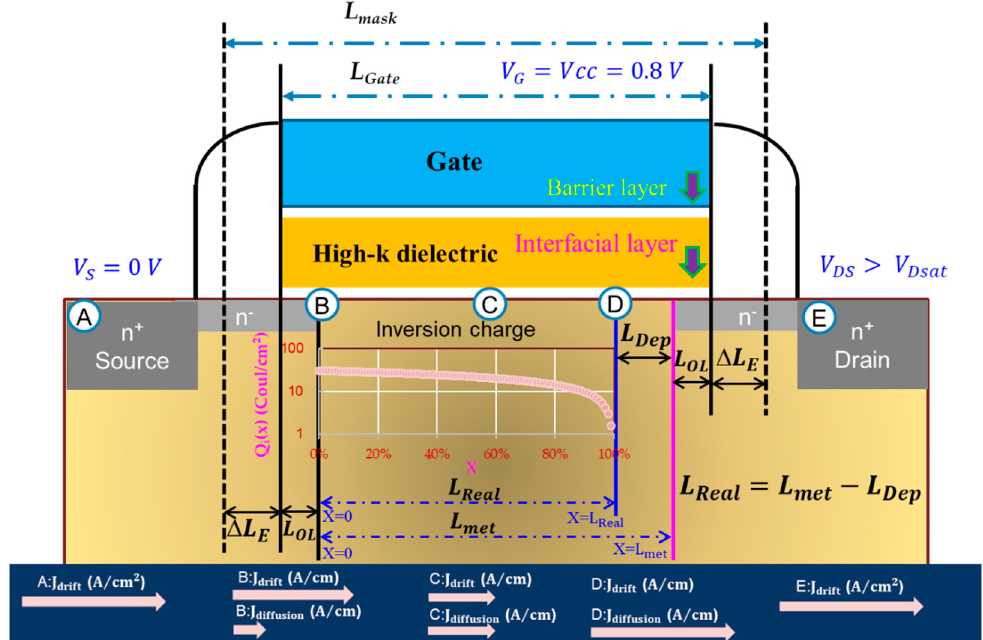
Figure 3. Distribution of inversion charge from checking points B to D .